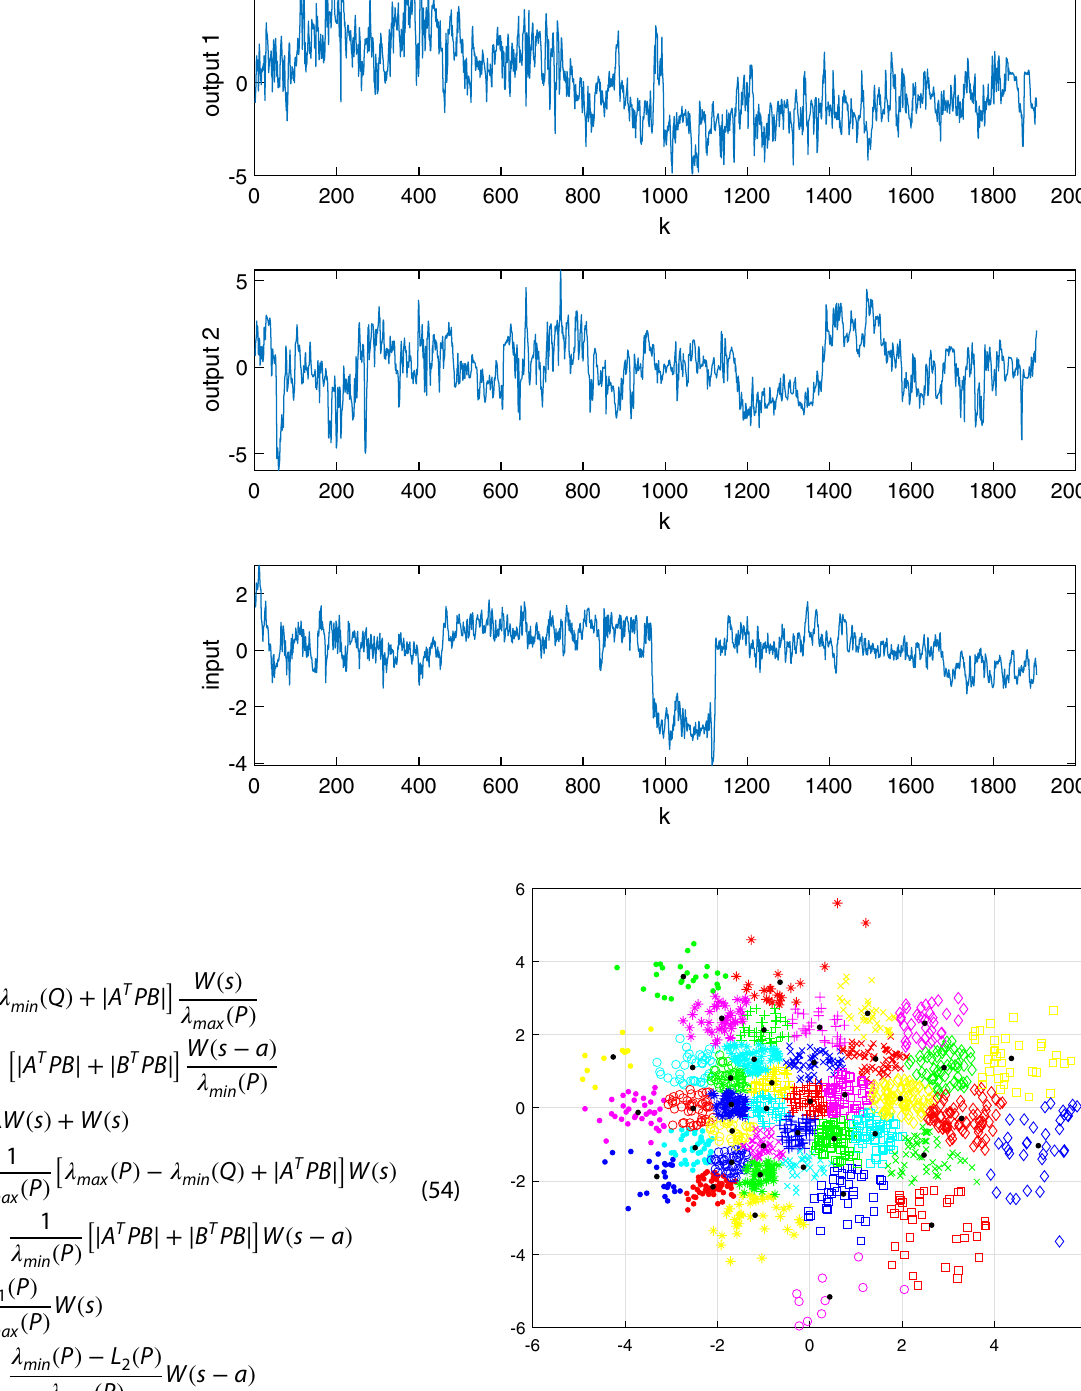
Fig. 3 Normalized input–out- put data